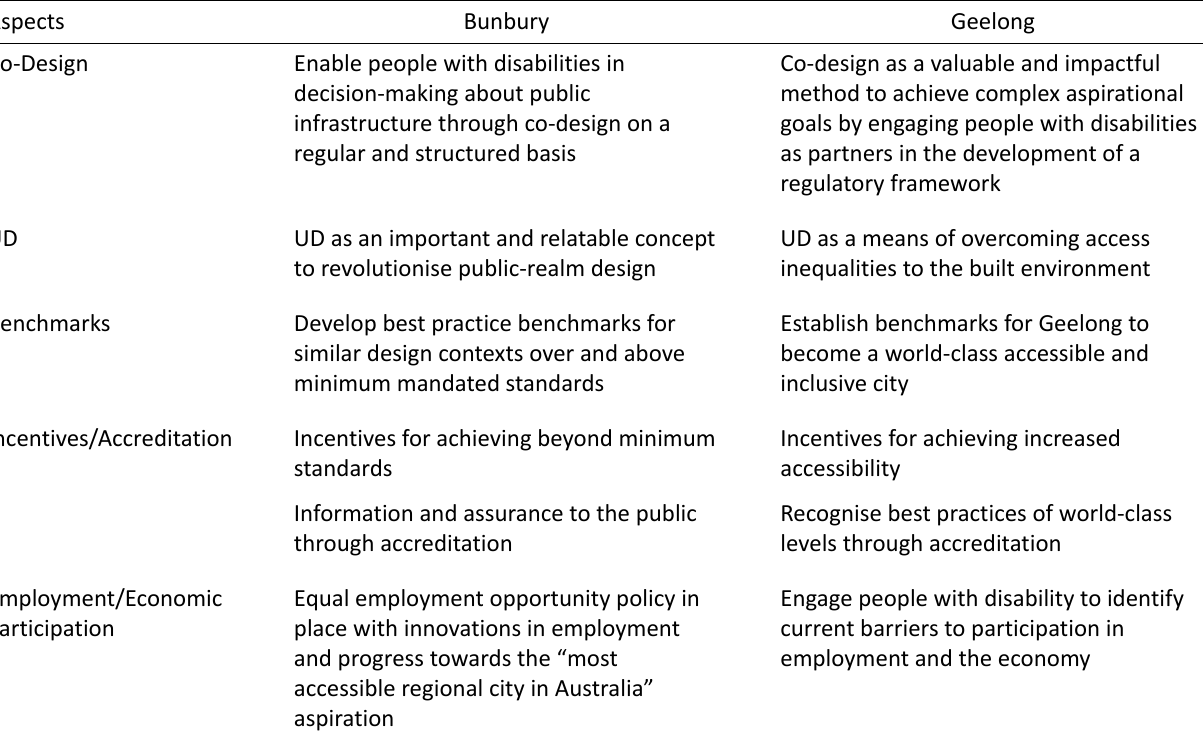
Table 1. Summary of